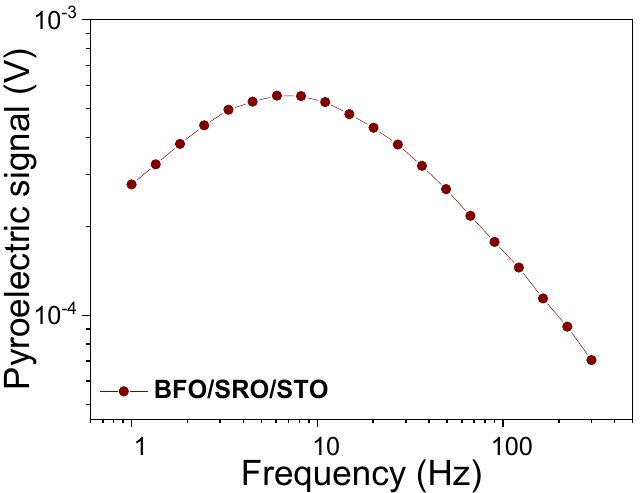
Figure 6. The dependence of pyroelectric signal as a function of modulation